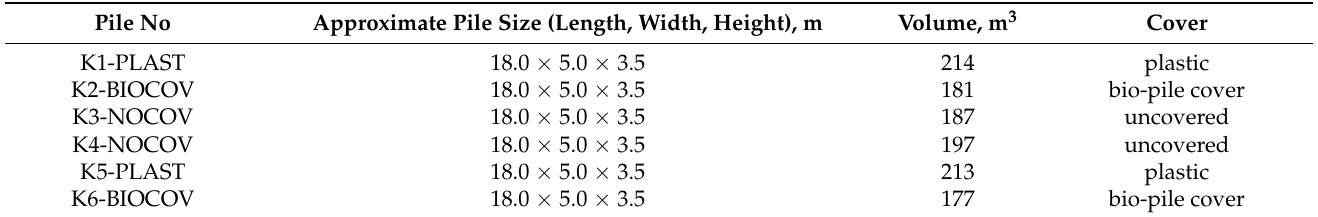
(Table 1). The plastic cover (Raniplast 112 g m − 2 , 120 µ m) was applied. Table 1. Details of the piles with different cover alternatives (uncovered, plastic cover, bio-pile cover).